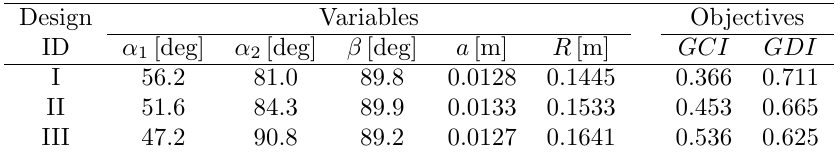
Table 3: Three Pareto-optimal solutions